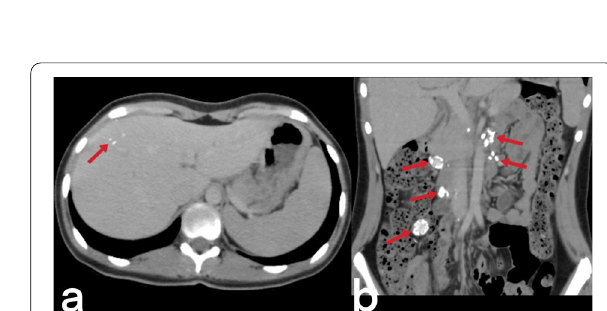
Fig. 23 Transverse abdomen CT image ( a ) of a 17-year-old female with known TB. Coarse calcifications in the liver parenchyma suggestive of TB sequela are noted. Coronal reformatted CT image of the same patient ( b ) reveals multiple lymphadenopathies with peripheral calcifications